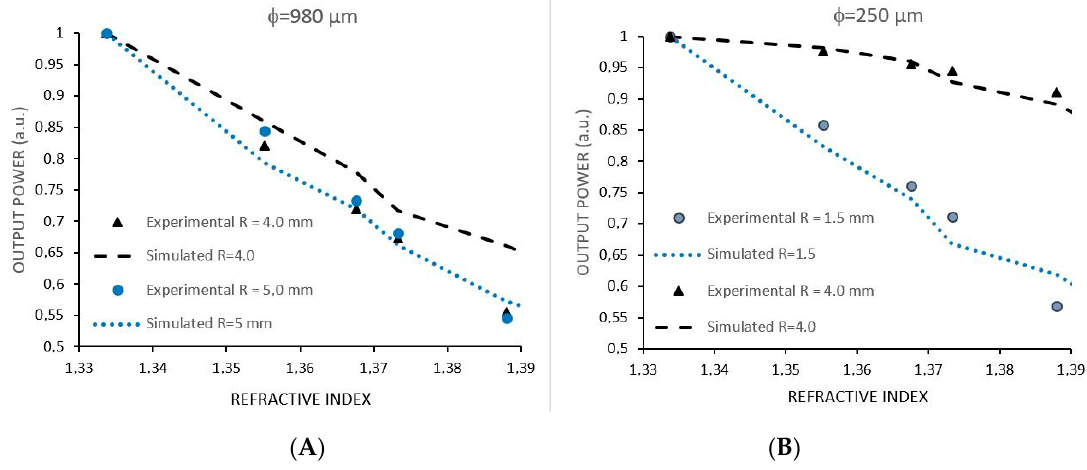
Figure 6. ( A ) Experimental results and simulation of U-Shaped sensors with 980 µm in diameter and radius of 4.0 and 5.0 mm. ( B ) Experimental results and simulation of sensors with 250 µm in diameter and radius of 1.5 and 4.0 mm. The measurement uncertainty is 0.005 RIU (refractive index unit).